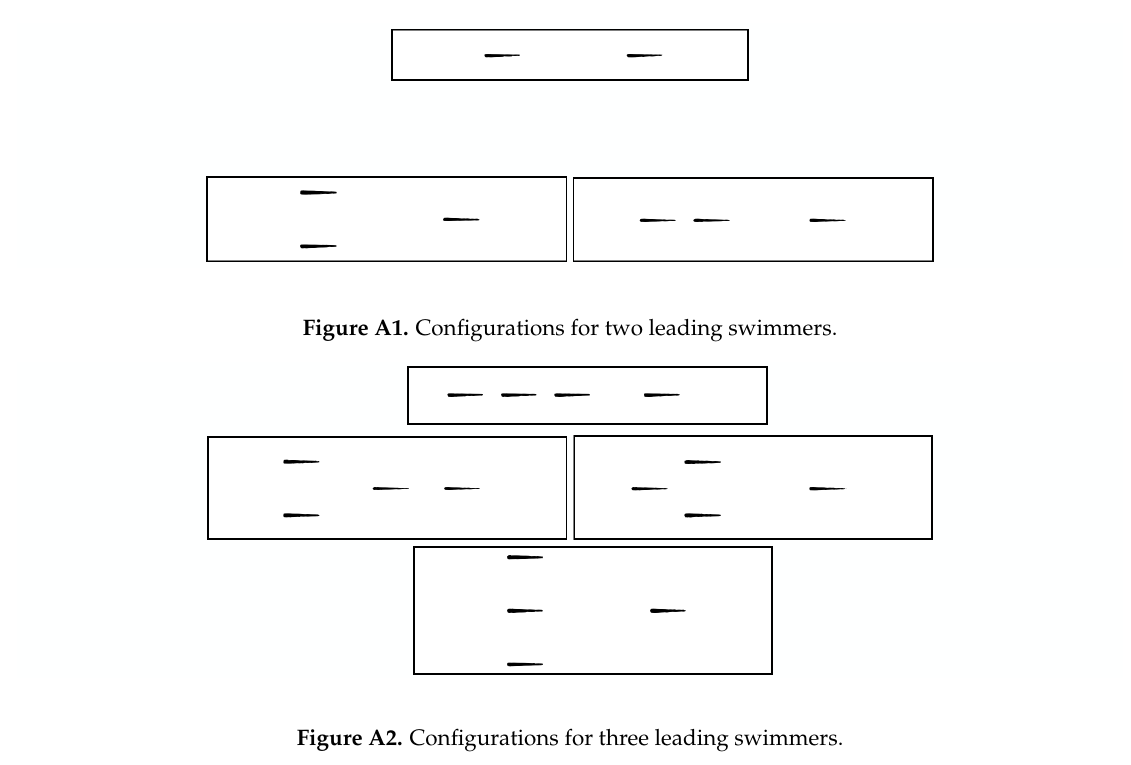
Figure A2. Configurations for three leading swimmers.